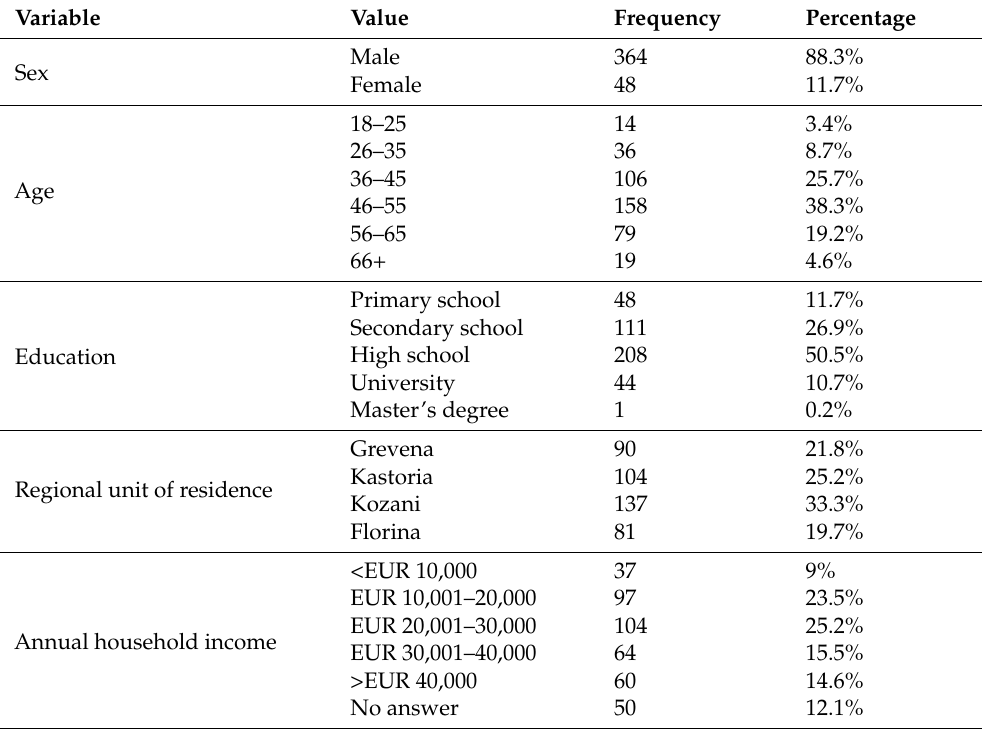
Table 1. Frequencies of sociodemographic profile of